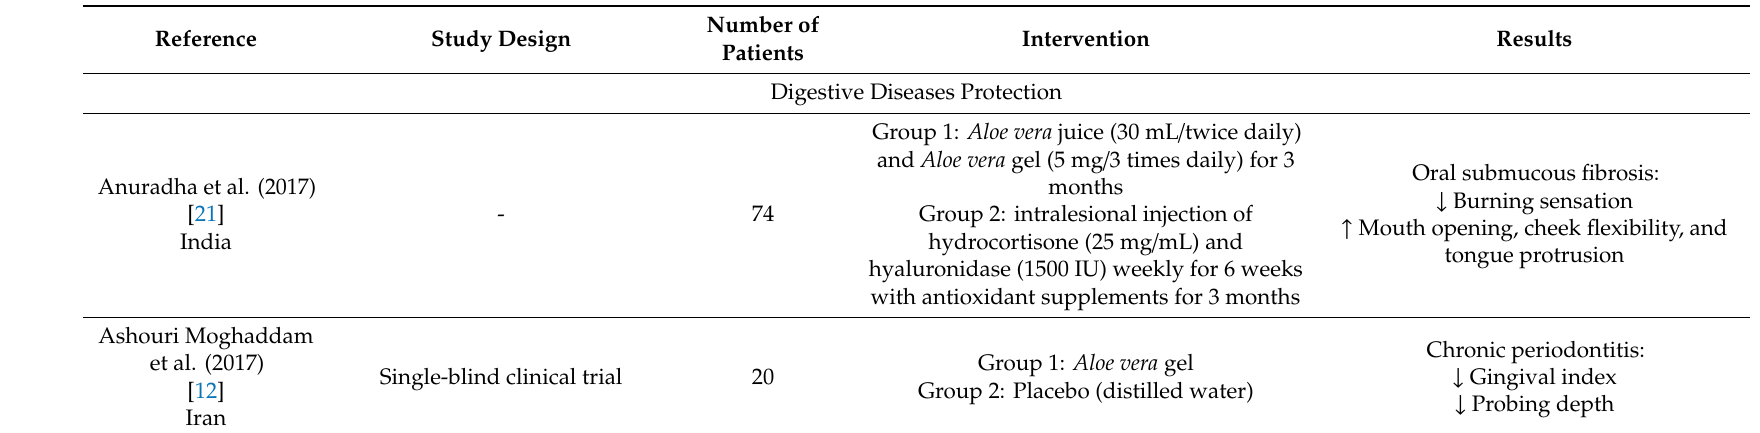
Table 3. Clinical trials with Aloe vera